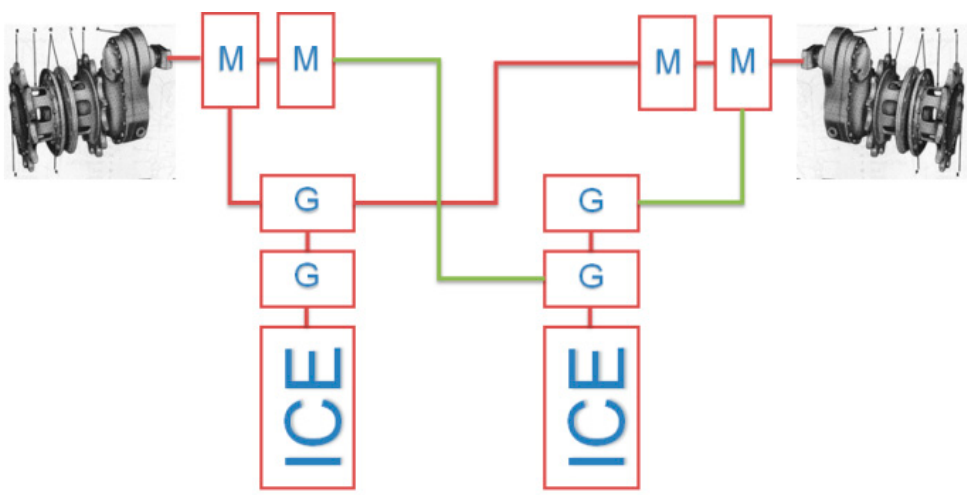
Figure 13. Dual Drive, dual engine configuration.